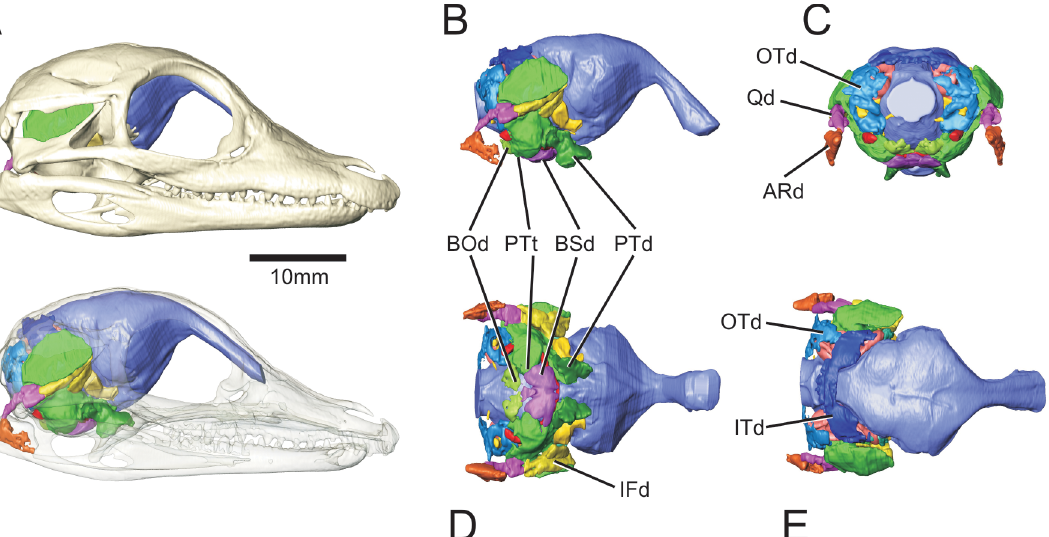
Fig 1. Full suite of paratympanic sinuses and diverticula in a perinatal Alligator mississippiensis (OUVC 10606). A. Rendered with skull and transparent skull. B. Left lateral view with brain endocast rendered in blue. C. Caudal view. D. Ventral view. E. Dorsal view. ARd , articular diverticulum; BOd, basioccipital diverticulum; BSd , basisphenoid diverticulum; IFd , infundibular diverticulum; ITd , intertympanic diverticulum; OTd , otoccipital diverticulum; PTd , pterygoid diverticulum; PTt , pharyngotympanic tube; Qd , quadrate diverticulum.